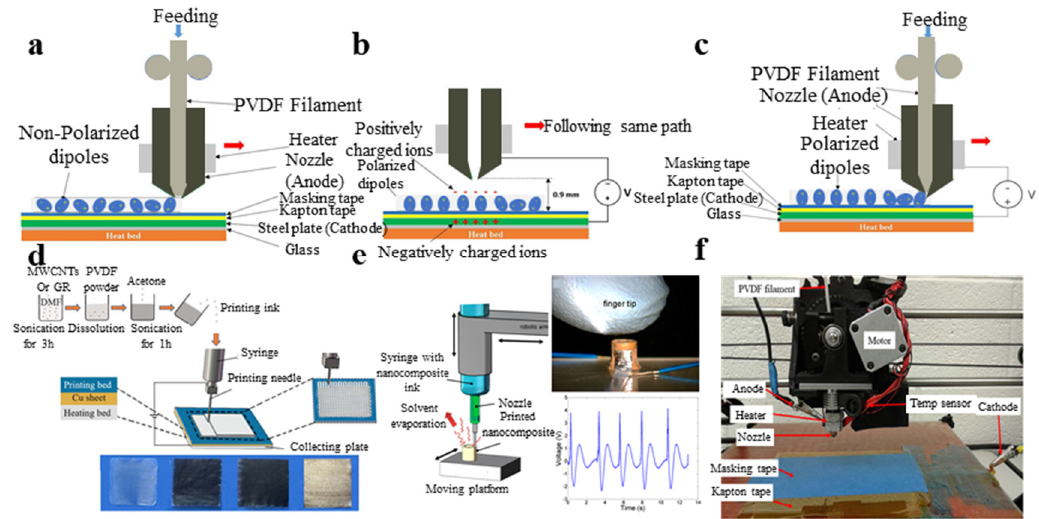
Figure 9. ( a ) Schematic of 3D printing of PVDF layer; ( b ) corona poling process; ( c ) simultaneous 3D printing and in-situ polarization; ( d ) 3D printing process and fabricated PVDF film [133]; ( e ) 3D cylindrical sensor’s piezoelectric voltage output when five finger taps [134]; and ( f ) optical diagram of 3D printing technique and corona poling process